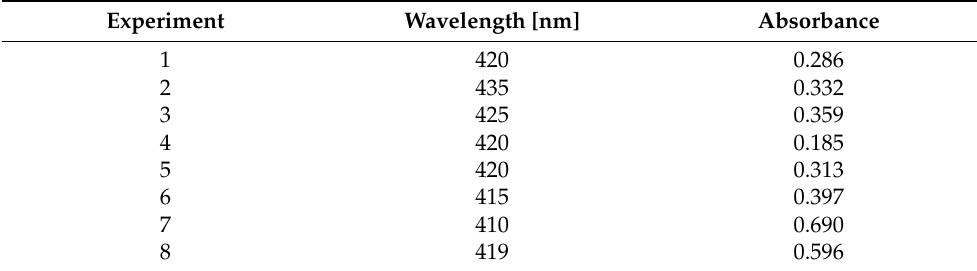
Table 3. The wavelength and absorbance data obtained from UV-Vis spectra.